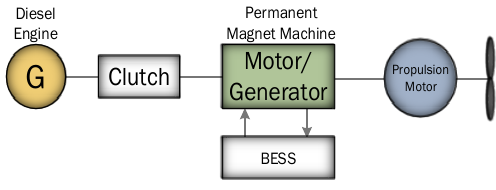
Figure 21. The Vision of the Fjords schematic